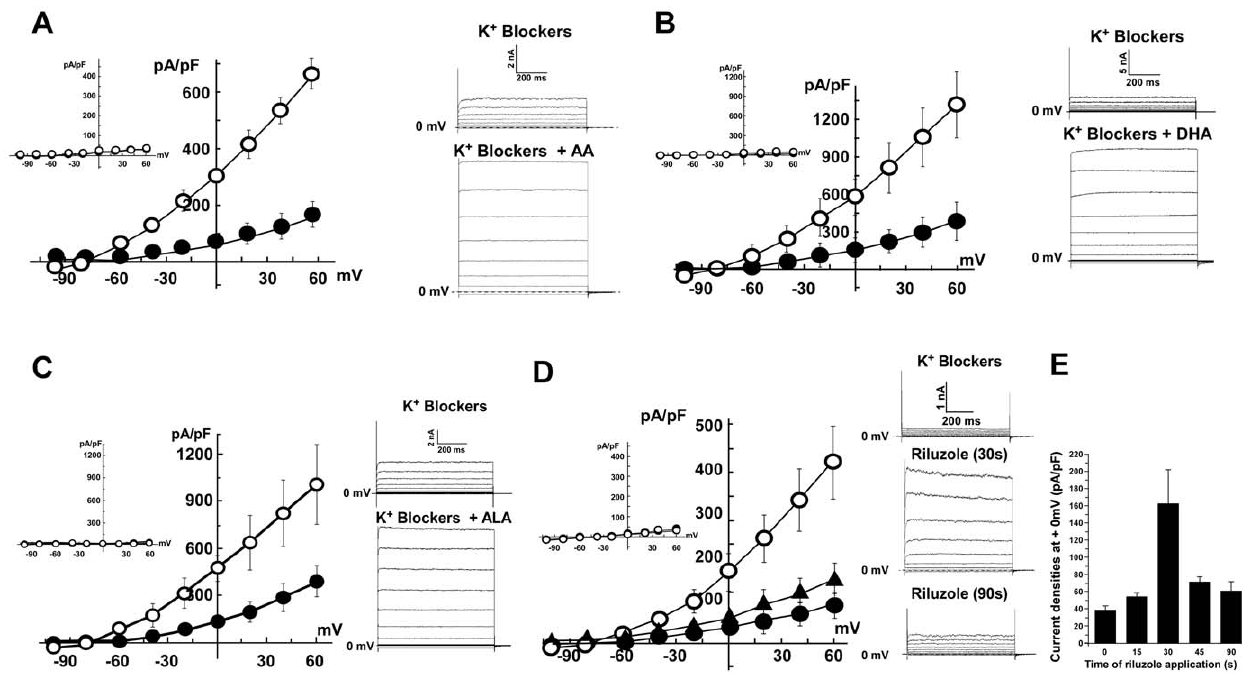
Figure 3. Pharmacological activation of h-TREK-1 current in whole cell patch clamp configuration. Currents were recorded in the presence of a cocktail of potassium channel inhibitors (K + blockers). A ) Current/potential curves and corresponding current traces obtained before (closed circle) and after (open circle) current activation by AA 10 m M (n=118). B ) Current/potential curves and corresponding current traces obtained before (closed circle) and after (open circle) current activation by DHA 10 m M (n=10). C ) Current/potential curves and corresponding current traces obtained before (closed circle) and after (open circle) current activation by ALA 10 m M (n=10). D ) Current/potential curves and corresponding current traces obtained before (closed circle) and after current activation by riluzole 100 m M (n=12) perfused during 30 s (open circle) or 90 s (closed triangle). Each pharmacological activator was tested on HEK-293 native cells (n=10) and current/potential curves were shown in the inset of each curve. E ) Current density values measured at 0 mV after different times of perfusion of 100 m M riluzole (n=10 at each time